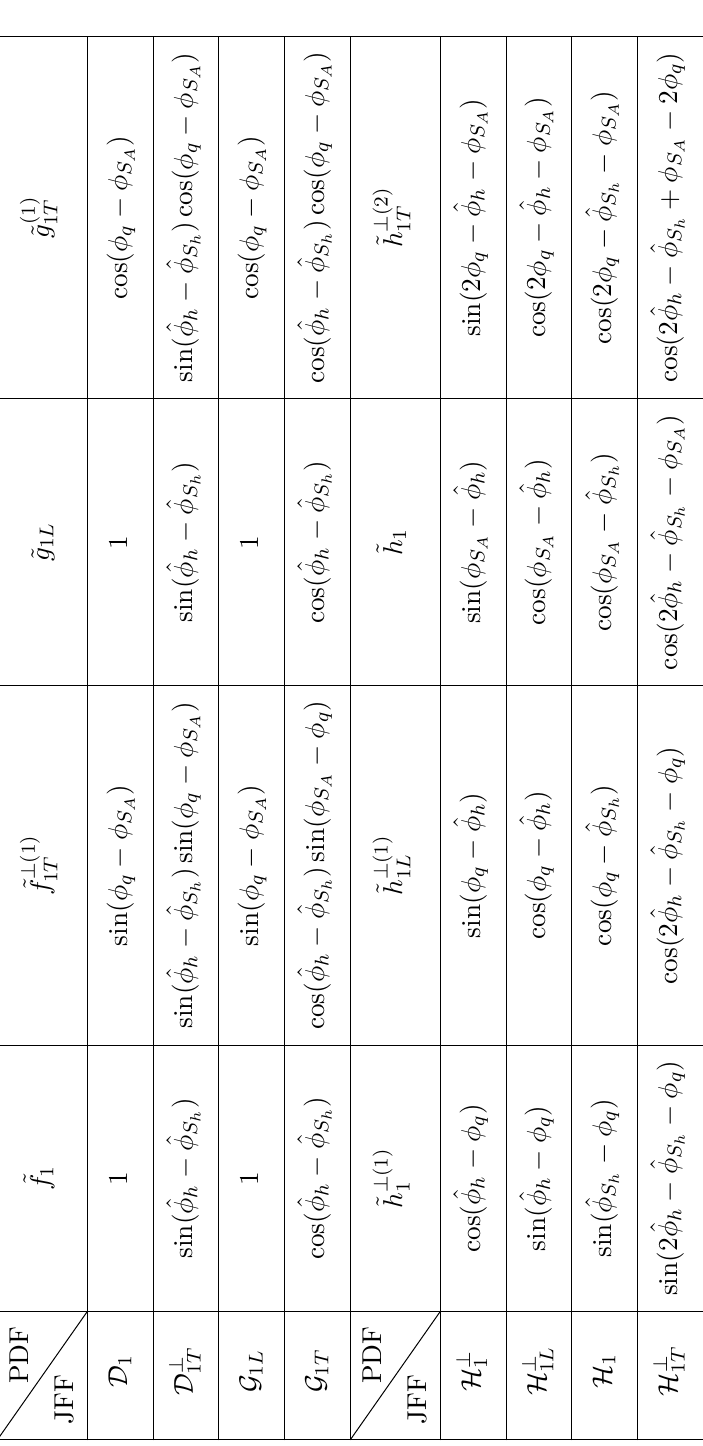
Table 5 . We summarize all the azimuthal asymmetries for e + p → e + jet ( h ) + X process, where the initial proton and produced hadron in jet have general polarizations and the initial electron is unpolarized or carries helicity. Parametrizations of structure functions given in the table are provided in appendix